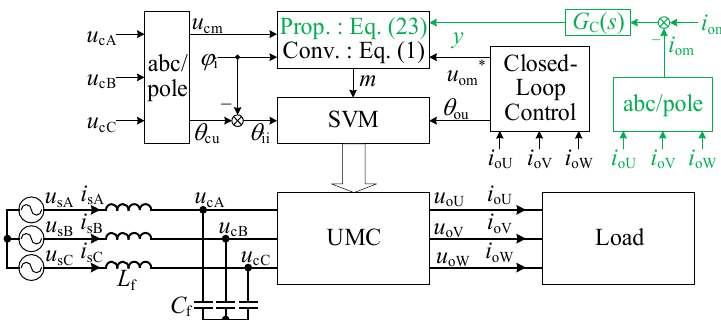
Figure 2. Control of the typical UMC system. Space vector modulation (SVM) is applied to generate the switching signals of UMC.